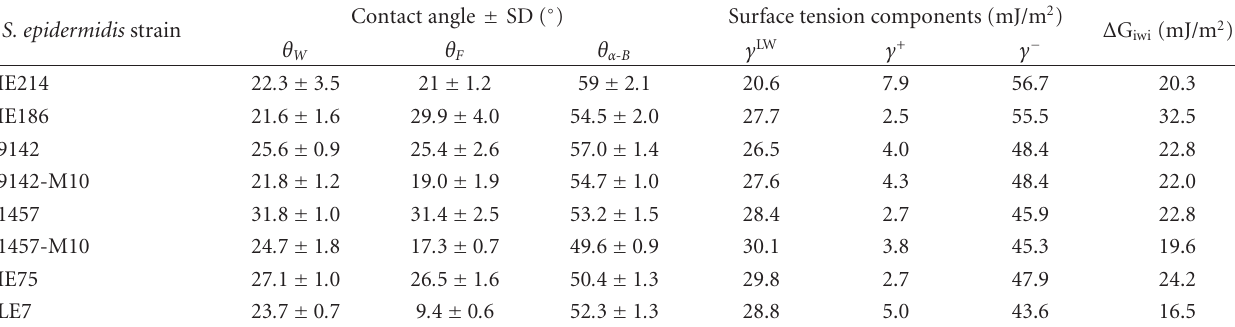
Table 2: Water ( θ W ), formamide ( θ F ), and α -bromonaphtalene ( θ α - B ) contact angles (in degrees), surface tension components, and hydrophobicity (in mJ/m 2 ) of the surface of S. epidermidis strains. S. epidermidis